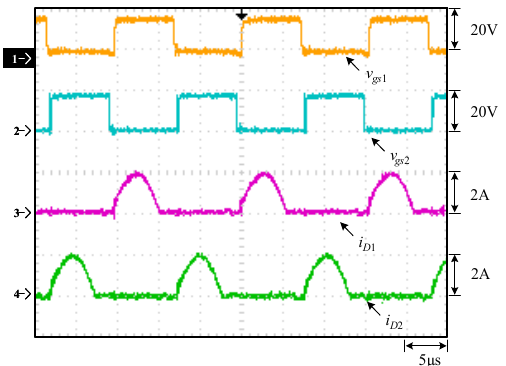
Figure 15. Waveforms at rated load: (1) v gs 1 ; (2) v gs 2 ; (3) i D 1 ; (4) i D 2 .